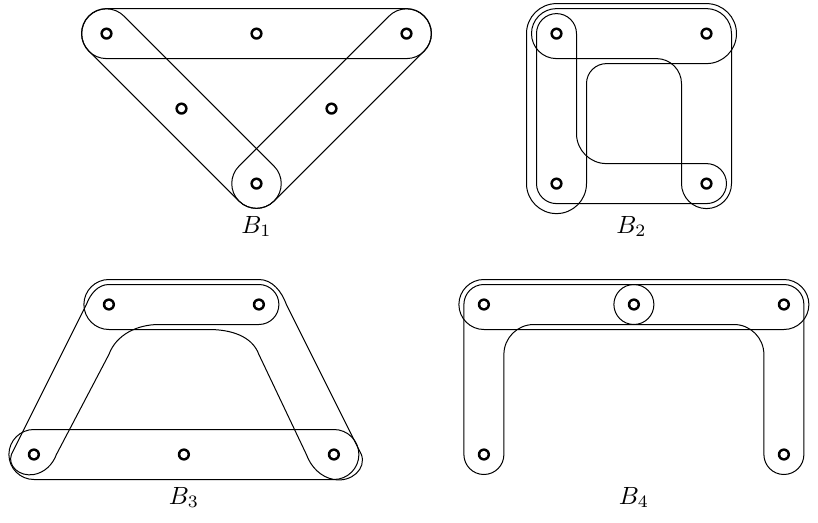
Figure 1: All 3-uniform Berge